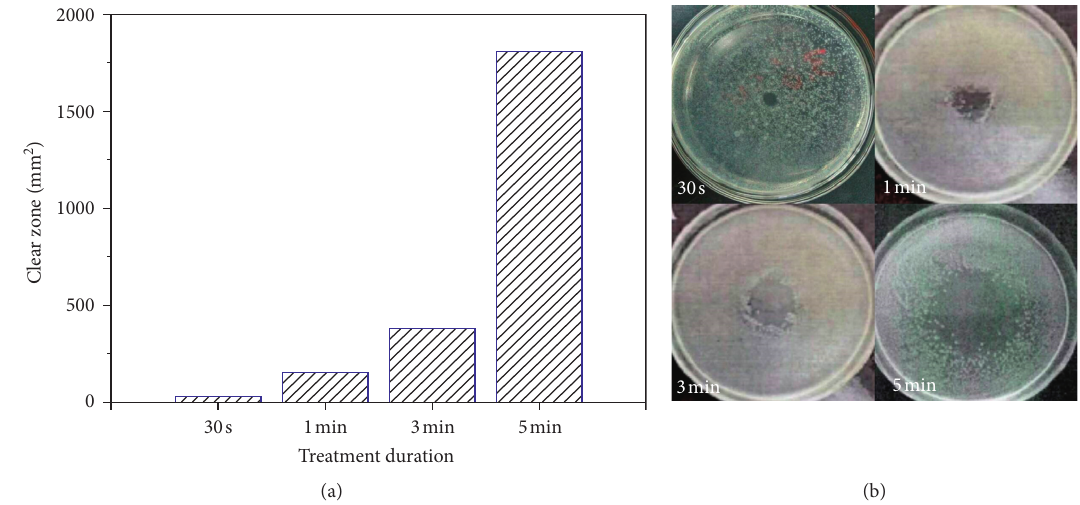
Figure 8: Growth inhibition of model bacteria after He-plasma jet exposure for different exposure times: (a) area of clear zone; (b) size of the plaque.